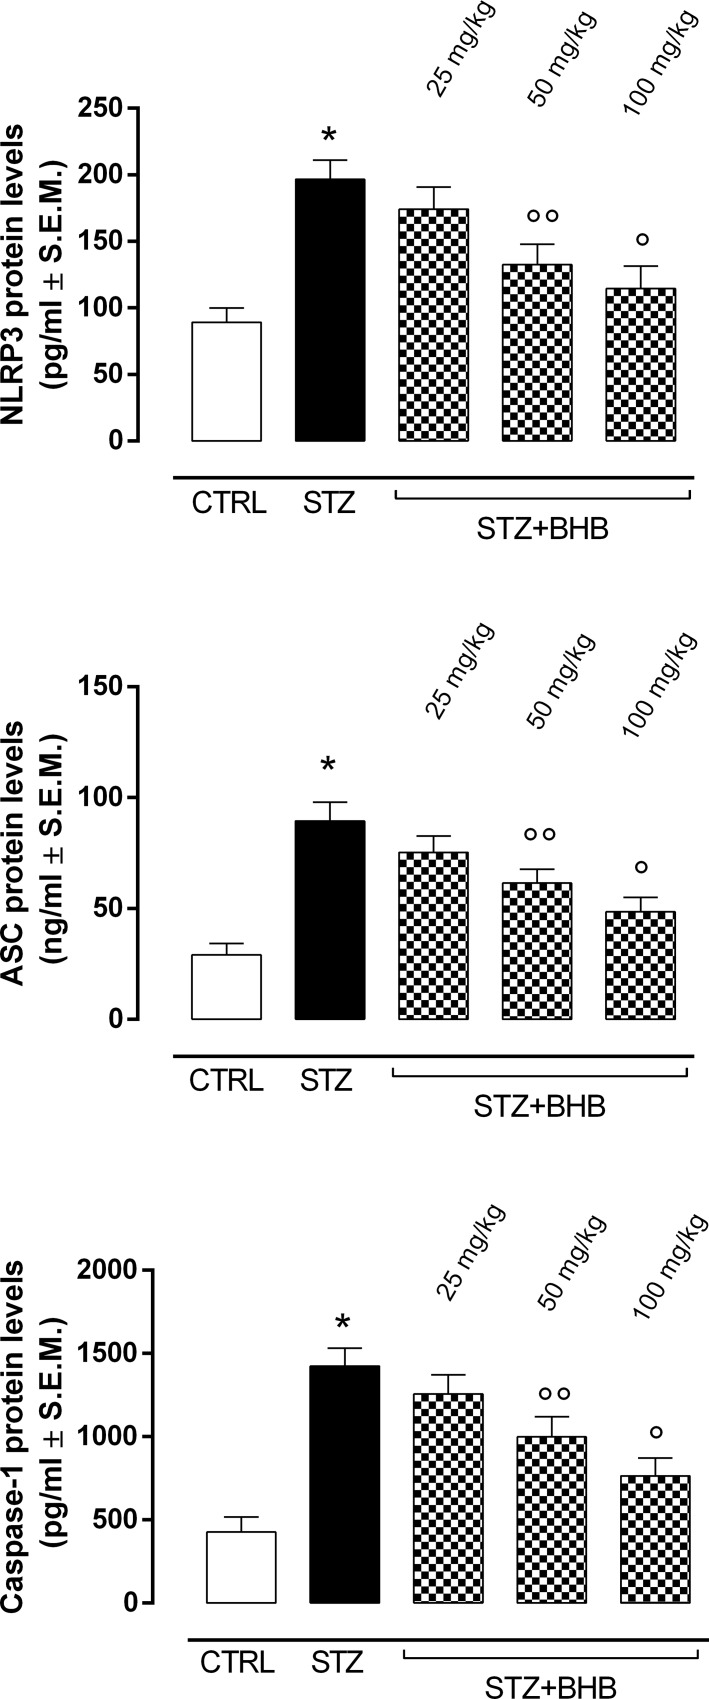
Determination of NLRP3 inflammasome activation markers.Detection of retinal NLRP3, ASC and caspase-1 levels by ELISA. Values are expressed as the mean of 10 observations ± S.E.M. CTRL = nondiabetic mice; STZ = diabetic mice; STZ+BHB = diabetic mice receiving BHB.*P < 0.01 vs CTRL; °°P < 0.05 vs STZ; °P <0.01 vs STZ.